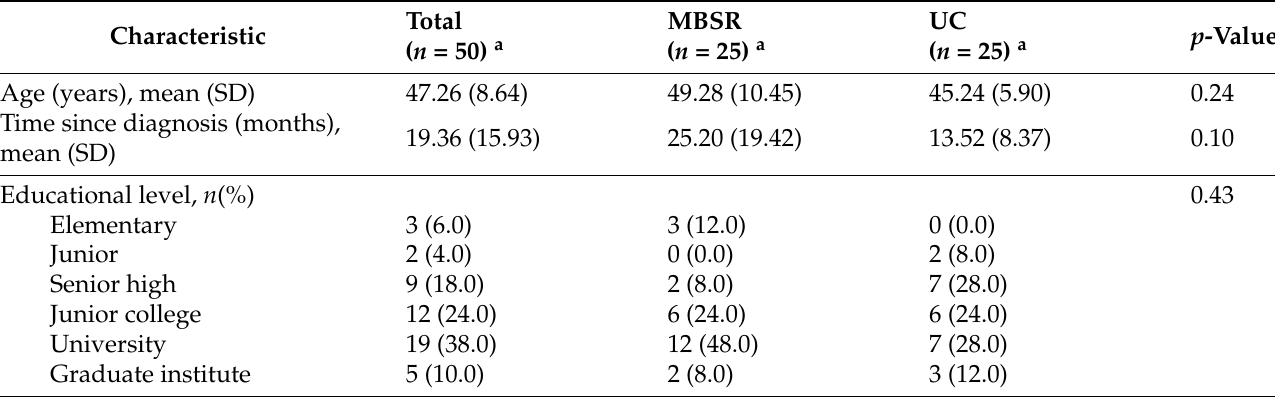
Figure 1. Diagram of participant progression. Table 2. The demographic and clinical characteristic of